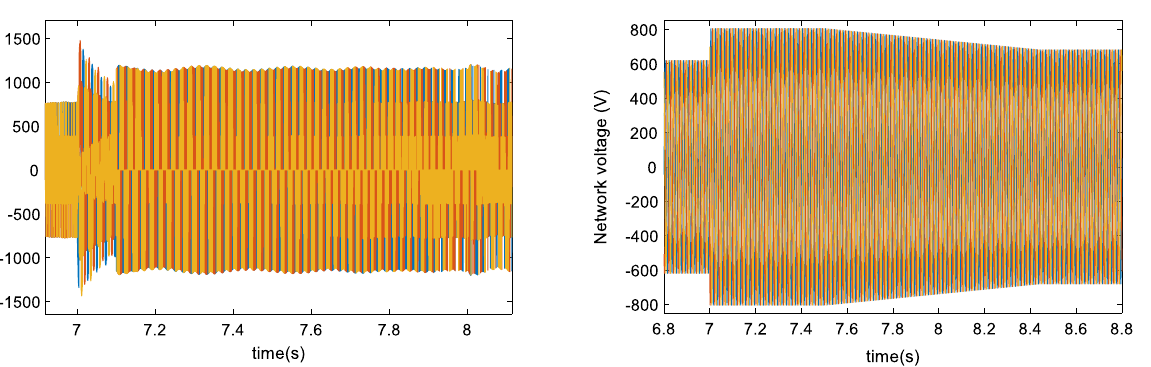
Fig. 25 Network voltage during symmetrical voltage swell (Australian network